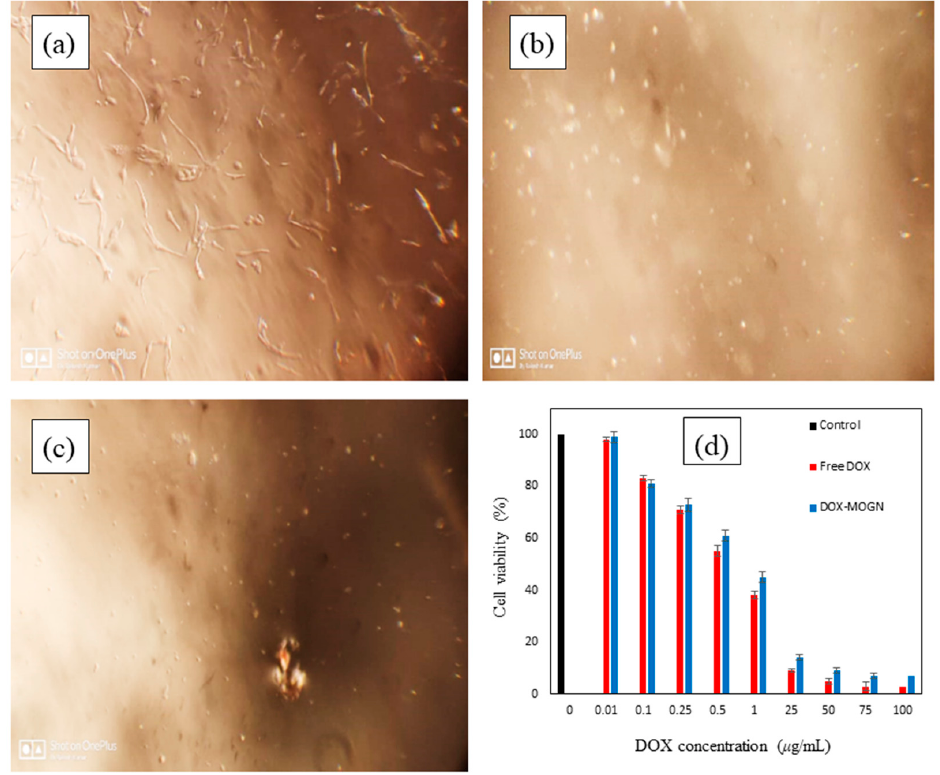
Figure 9. Images of the control (untreated RD cells) ( a ), free DOX treated RD cells ( b ), DOX–MOGN treated RD cells ( c ); in vitro cell viability of RD cells treated with different DOX concentrations ( d ).